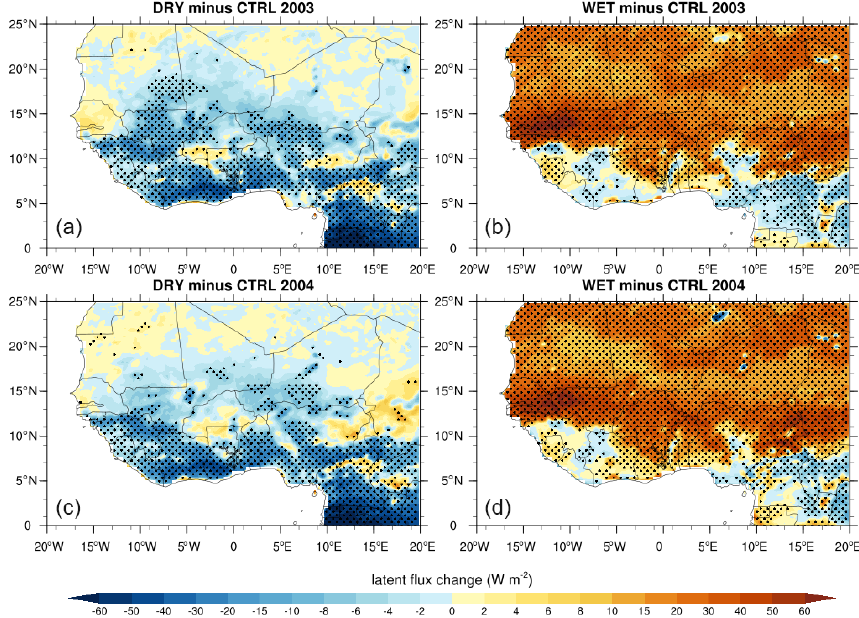
Figure 16. Same as Fig. 12 but for latent heat fluxes (in Wm − 2 ).